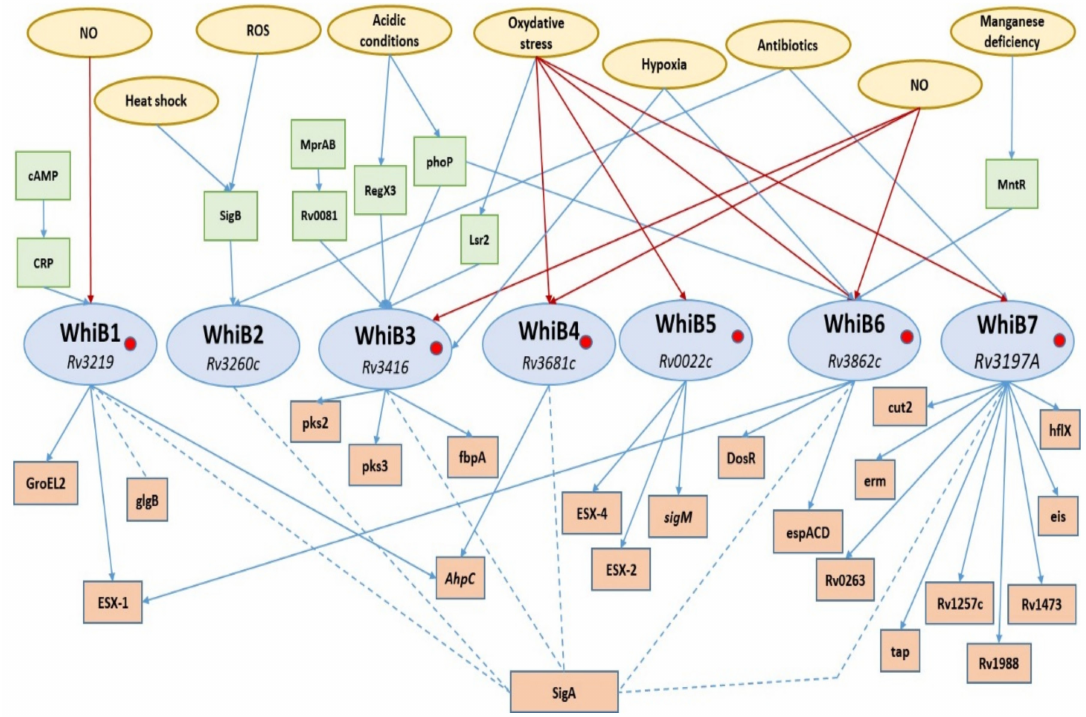
Figure 3. Regulation network of Mtb WhiB proteins. The red circle indicates that the protein displays a disulfide reductase activity. Blue arrows indicate regulation (up- or downregulation), while blue dashed lines indicate an interaction between WhiB proteins and SigA factor [124,125,138,146]. Red arrows focus on the WhiB proteins regulated by oxidative stress and